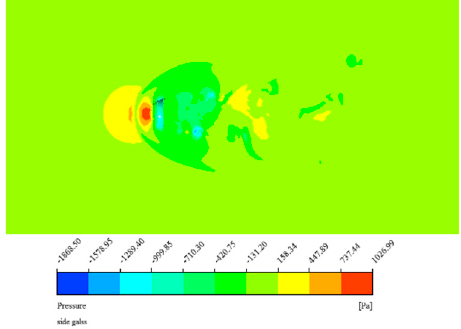
Figure 4. Distribution of pressure at the bottom panel of the side mirror.